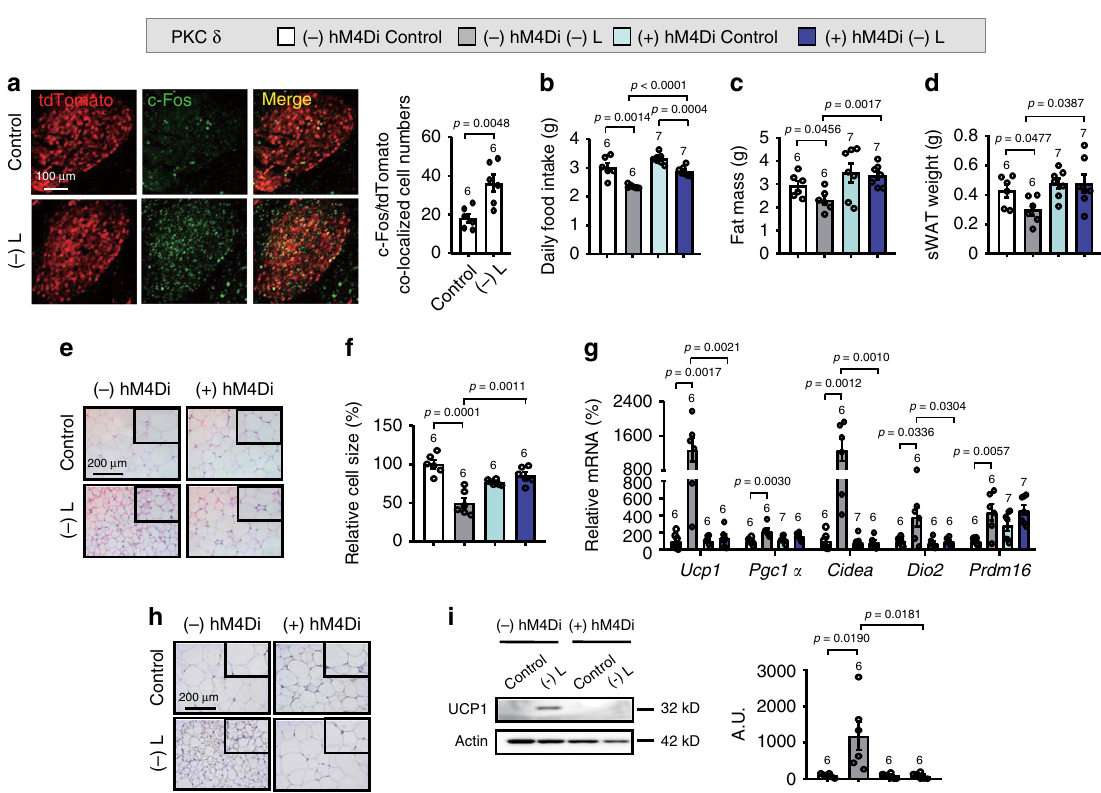
Fig. 2 Silencing PKC- δ neuronal activity blocks WAT browning under leucine deprivation. a Immuno fl uorescence (IF) staining for tdTomato (red), c-Fos (green) and merge (yellow) in central amygdala (CeA) sections (left), and quanti fi cation of c-Fos and tdTomato colocalized cell numbers (right). b Daily food intake. c Fat mass by NMR. d Subcutaneous WAT (sWAT) weight. e Representative images of hematoxylin and eosin (H&E) staining of sWAT. f sWAT cell size quanti fi ed by Image J analysis of H&E images. g Gene expression of Ucp1, Pgc1a, Cidea, Dio2 , and Prdm16 in sWAT by RT-PCR.